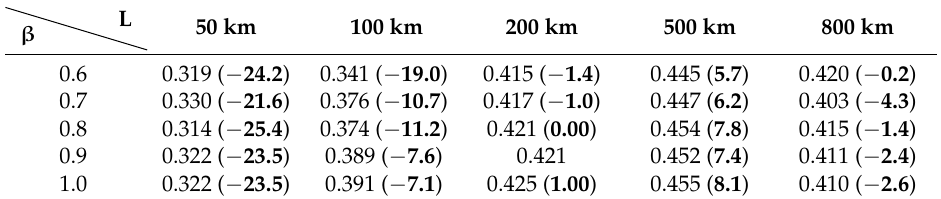
Table 8. As in Table 7, but for the sensitivity experiments for the case C-14 relative to Exp-B3. L 50 km 100 β